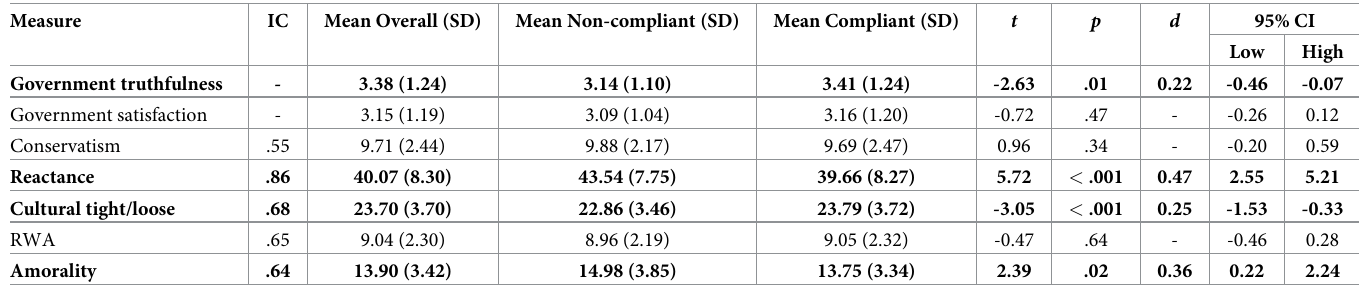
Table 7. Series of t-tests on the difference between classes on political and cultural variables (df = 1573 for all variables but amorality [df = 409]).